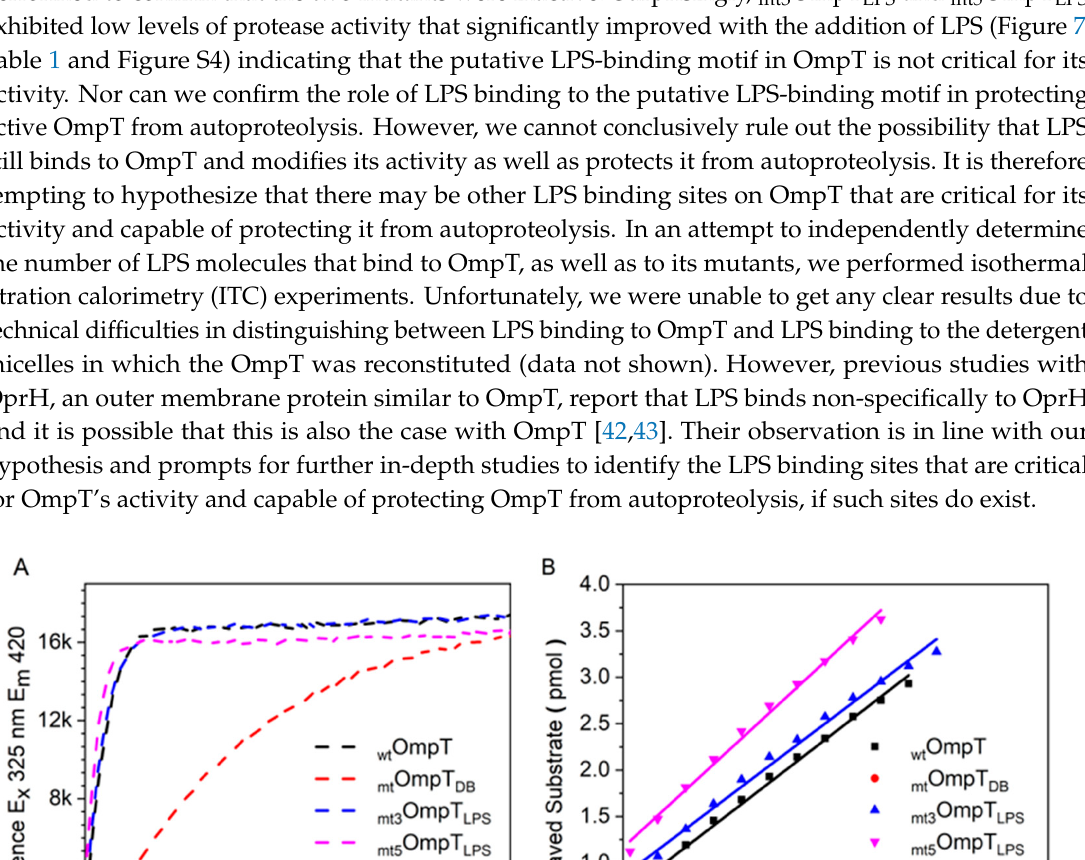
Table 1. Specific activity of wild type OmpT and the various mutants used in this study.